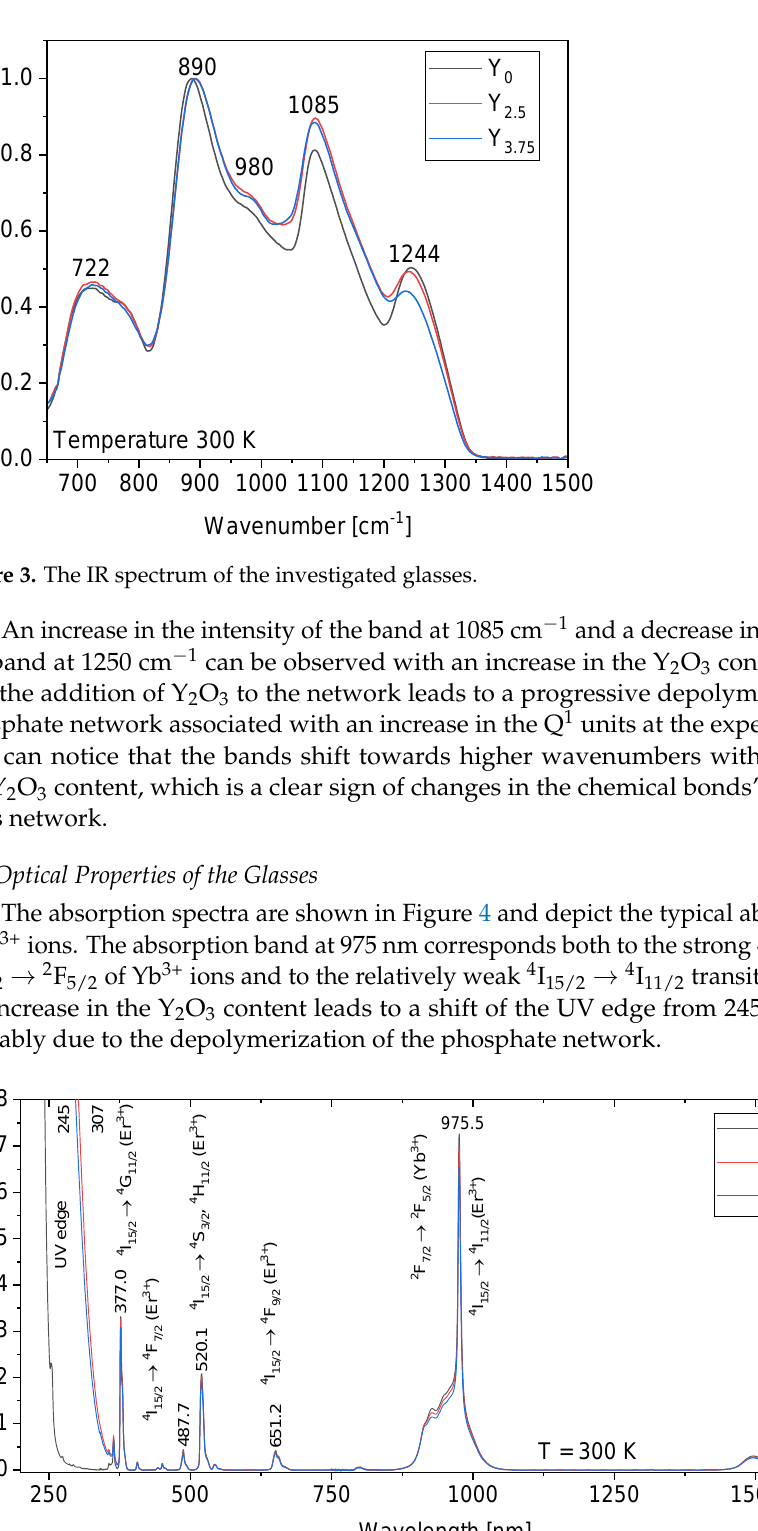
1085 cm − 1 with the shoulder at 980 cm − 1 can be assigned to the asymmetric and symmetric stretching vibrations of Q 1 units, respectively [38,39].